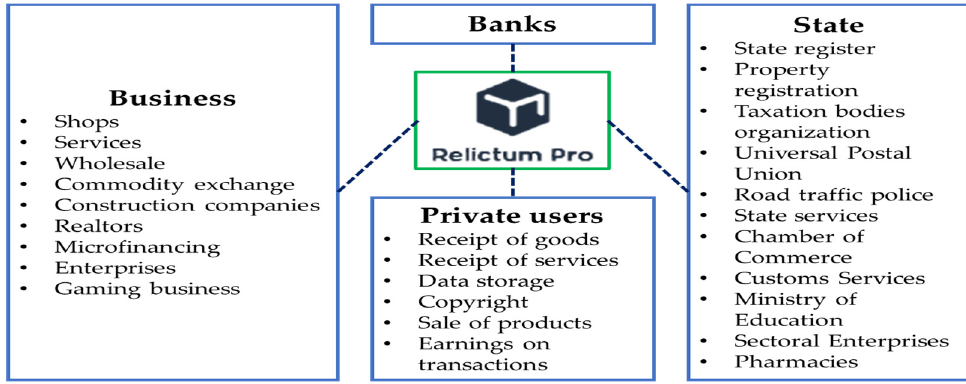
Figure 9. Relictum Pro Framework . Figure 9.